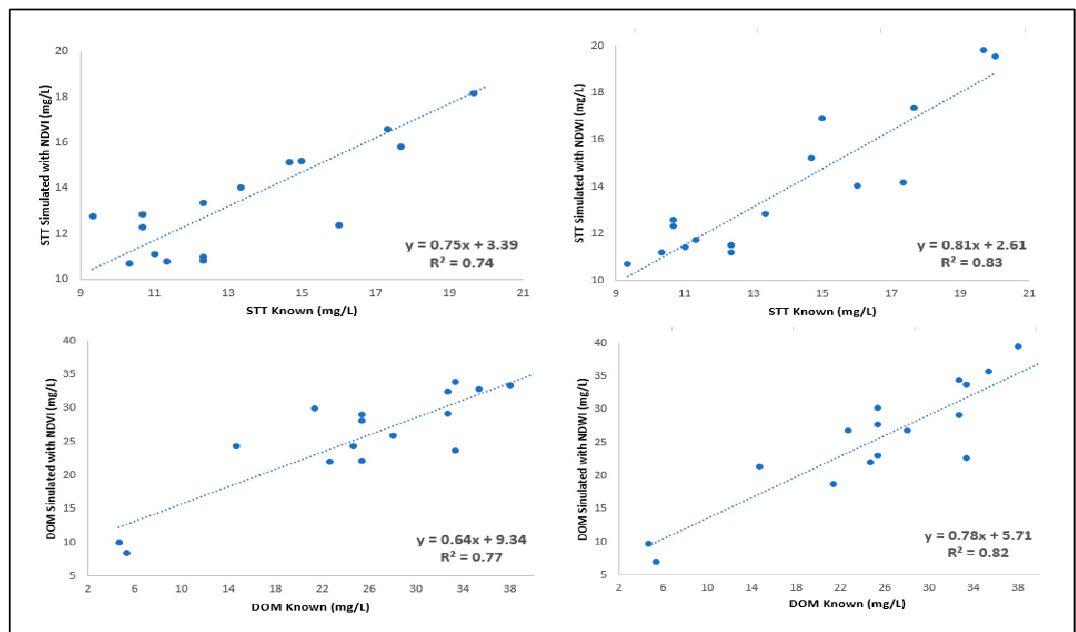
Figure 8. Scatter plot of SST and DOM known and simulated considering the b 4 and b 9 bands in obtaining the NDVI and NDWI indices.